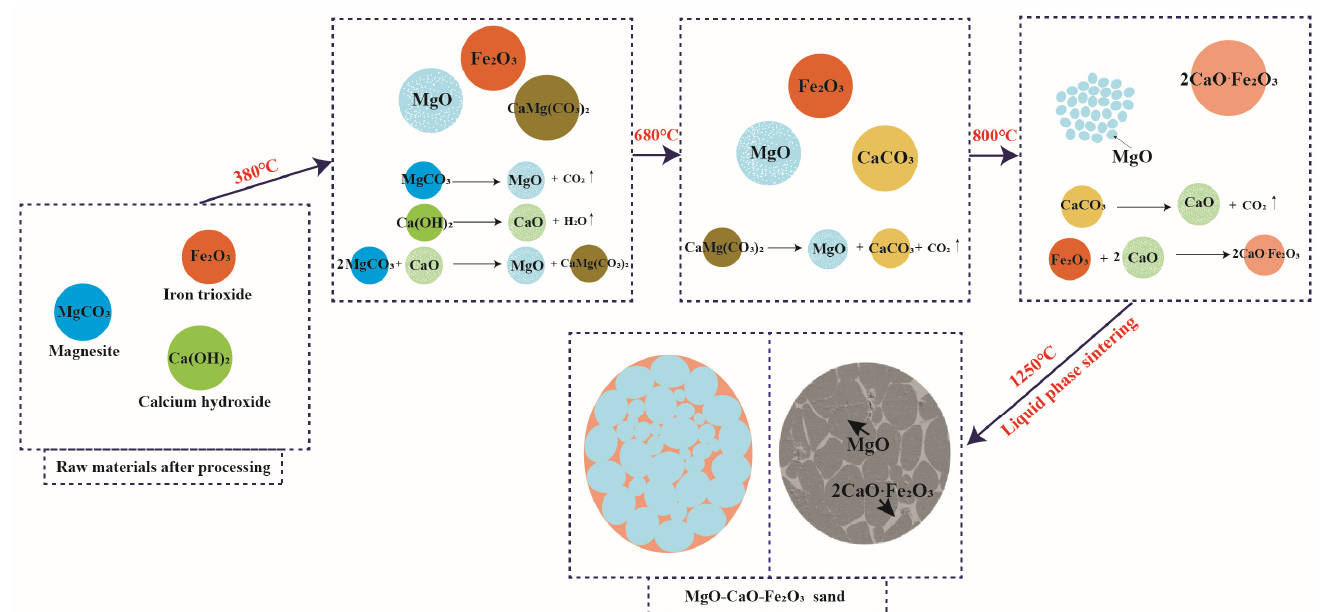
Figure 8. Synthesis mechanism of the MgO ‐ CaO ‐ Fe 2 O 3 clinker.